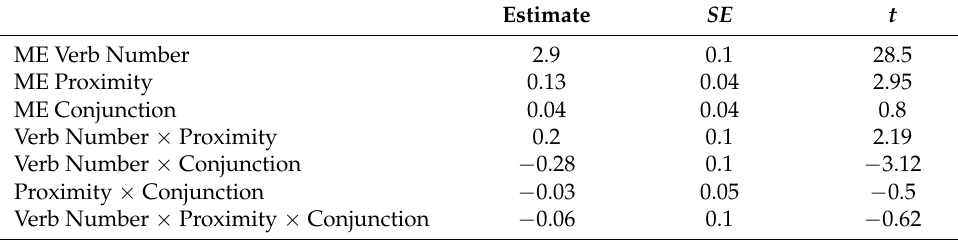
Table 4. Summary of the statistical results for number conflict conditions, Experiment